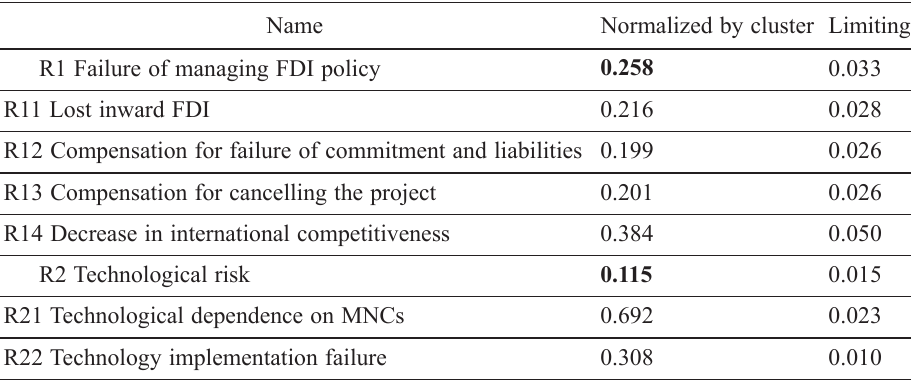
Table 13. Priorities of the elements in the risk sub-network